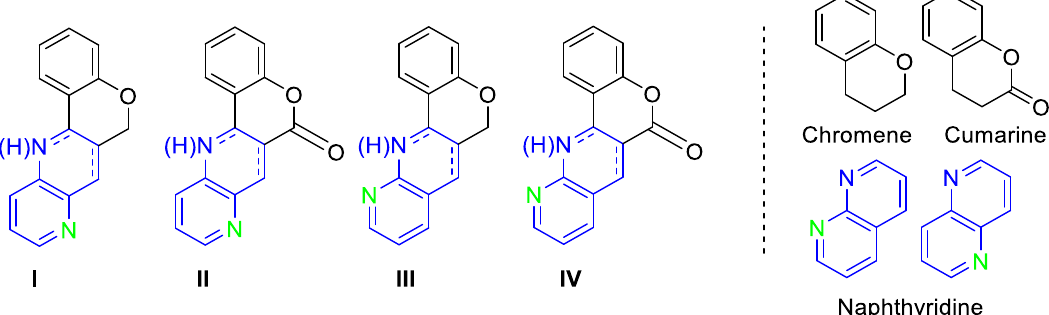
Figure 1. Structure of the hybrid molecules prepared for their biological evaluation.